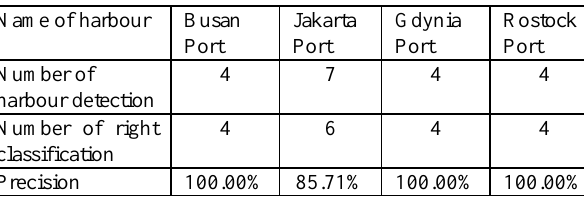
Table 2. Precision for ROI classification on each